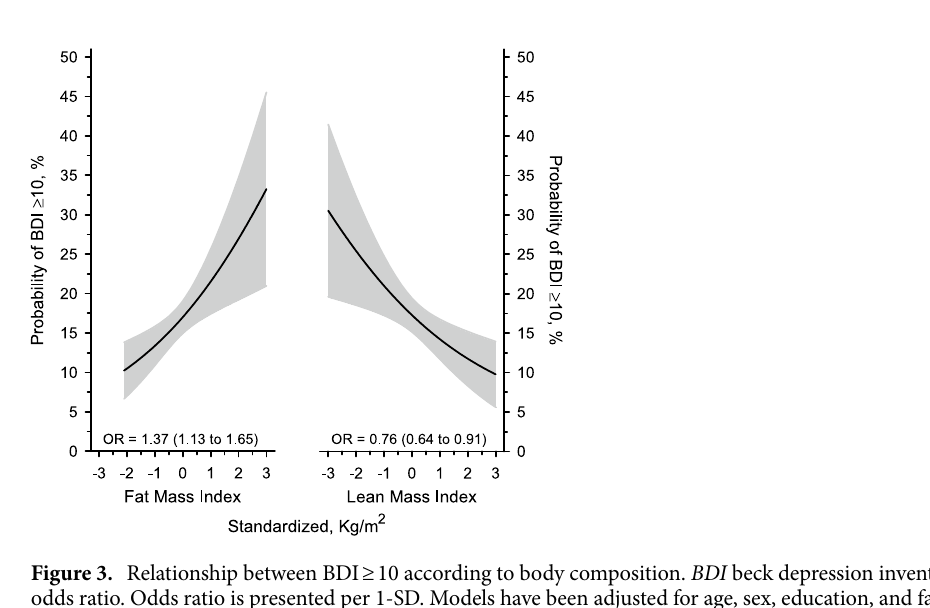
Figure 2. Percentage of BDI ≥ 10 according to body composition group. FMI fat mass index, LMI lean mass index, BDI beck depression inventory. The model has been adjusted for age, sex, education, and fasting plasma glucose concentration.